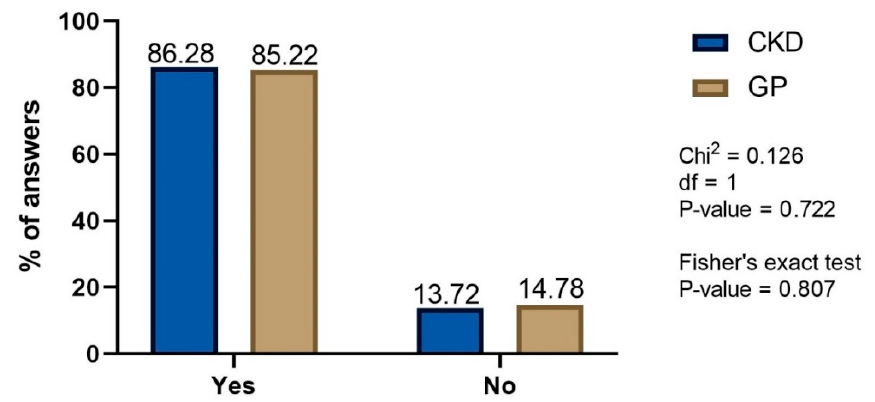
Figure 5. The proportion of patients aware of potential side effects of NSAIDs or analgesics.